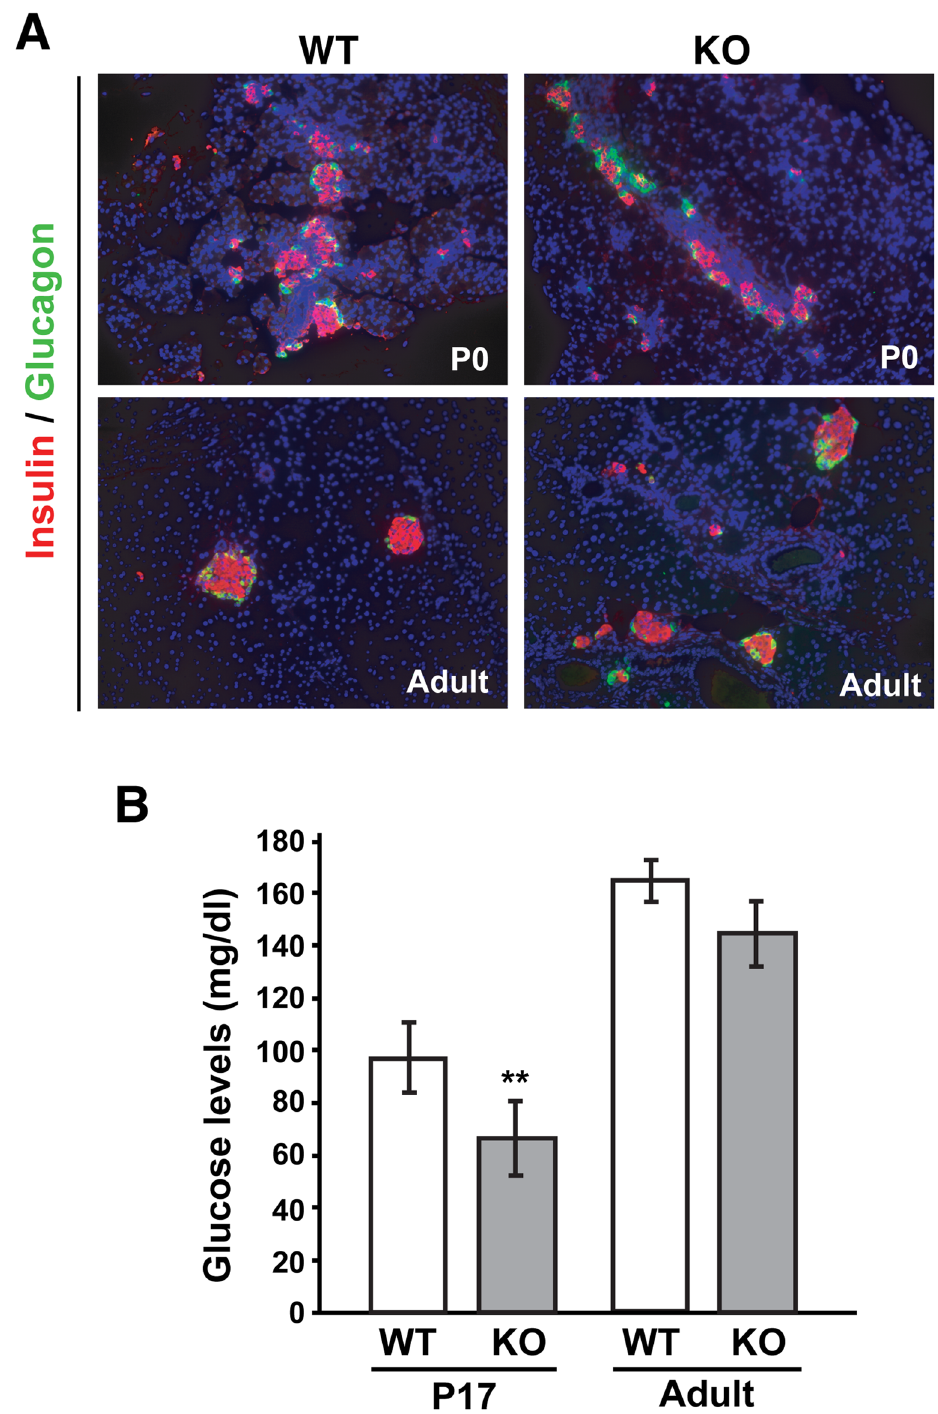
Figure 3. Characterization of the endocrine pancreas. ( A ) Pancreatic sections of P0 and adult mice were immunostained for the β-cell marker insulin and α-cell marker glucagon. ( B ) Blood glucose levels were measured in P17 and adult mice. Data represent means ± SEM. **p <